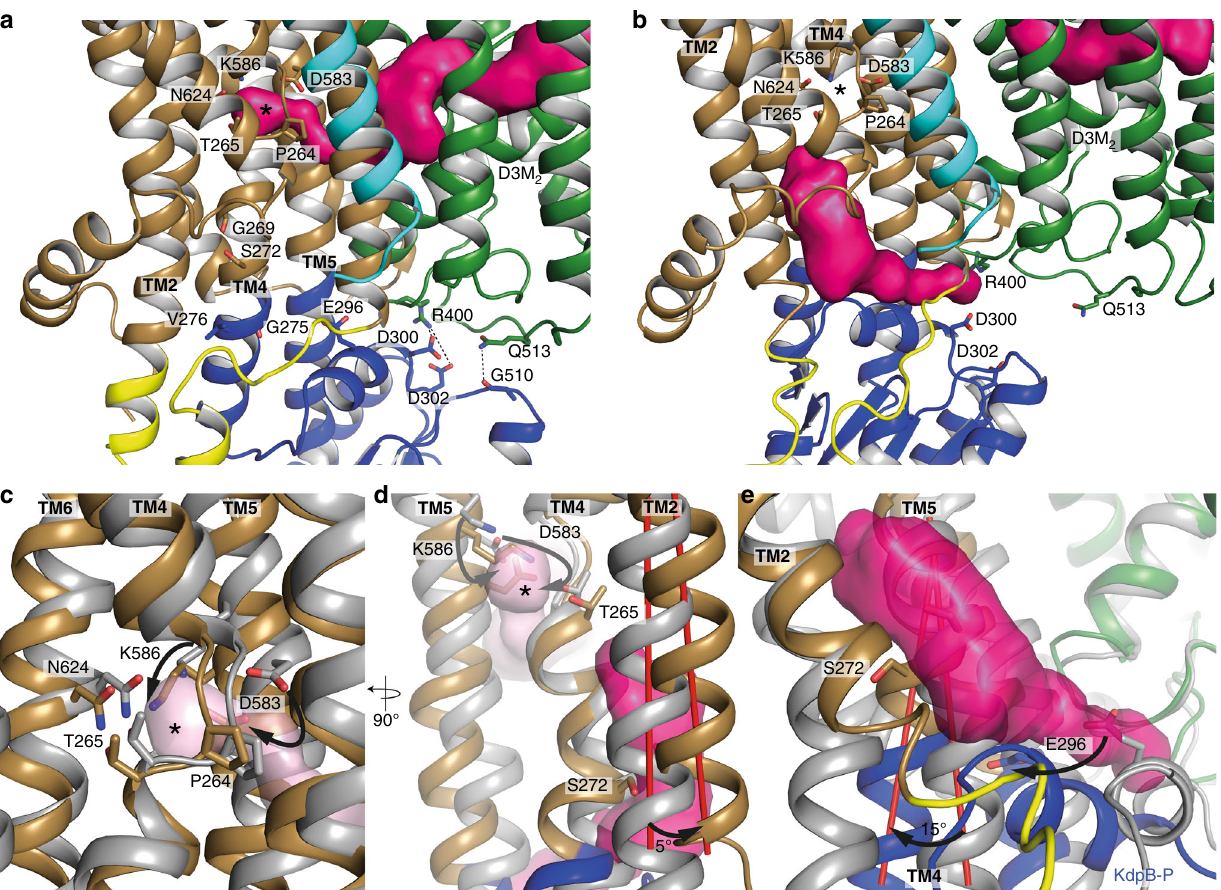
Fig. 4 Conformational changes during state 1 to state 2 transition. a Blocked cytoplasmic exit site in state 1. Residues Arg400 (KdpA) and Asp300, Asp302 (KdpB) and Gln513 (KdpA), and Gly510 (KdpB), respectively, form salt bridges at the P domain-KdpA interface. Further blockage of the exit tunnel is achieved by residues Gly269, Ser272, Gly275, Val276 and Glu296 of KdpB. b Open exit tunnel in state 2 ranging from the canonical binding site (Pro264, Thr265, Asp583, Lys586, and Asn624) to the cytoplasmic exit site, where residues Arg400 (KdpA) and Asp300, Asp302 (KdpB) as well as Gln513 (KdpA) and Gly510 (KdpB) do not interact. c Close-up superposition of the canonical binding site in state 1 (gray) and state 2 (color) with entrance tunnel (light pink density). Key residues Pro264, Asn624, Thr265, Asp583, and Lys586 undergo large conformational changes distorting the binding site. d , e Superposition of transmembrane helices of KdpB in state 1 (in gray) and state 2 (color) highlighting the opening of the exit tunnel. TM2 rotates by 5° ( d ) and TM4 by 15° ( e ) opening up the tunnel towards the canonical binding site. In particular the delocalization of residues Ser272 within TM4 and Glu296 in the P domain of KdpB allow the tunnel formation. Tunnel densities depicted in light and dark pink (entrance and exit tunnel, respectively). Asterisk (*) in a – d indicates the canonical binding site. Movement of the conserved residues Asp583 and Lys586 is highlighted with black and gray arrows in c and d , respectively. View in d is rotated by 90° to the left from fi gures a –